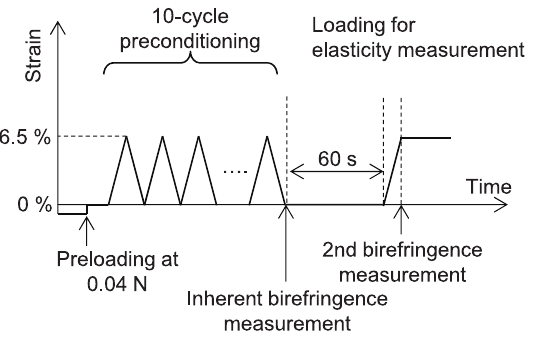
Figure 4. The time chart of strain applied during the measurement. Prestress of 0.04 N was applied to remove slack of the sample. Ten-cycle preconditioning was applied by loading and unloading from 0–6.5 % strain with a speed of 1.8 mm/min. After 10 s of preconditioning, the sample was extended from 0–6.5 % strain with the same speed.